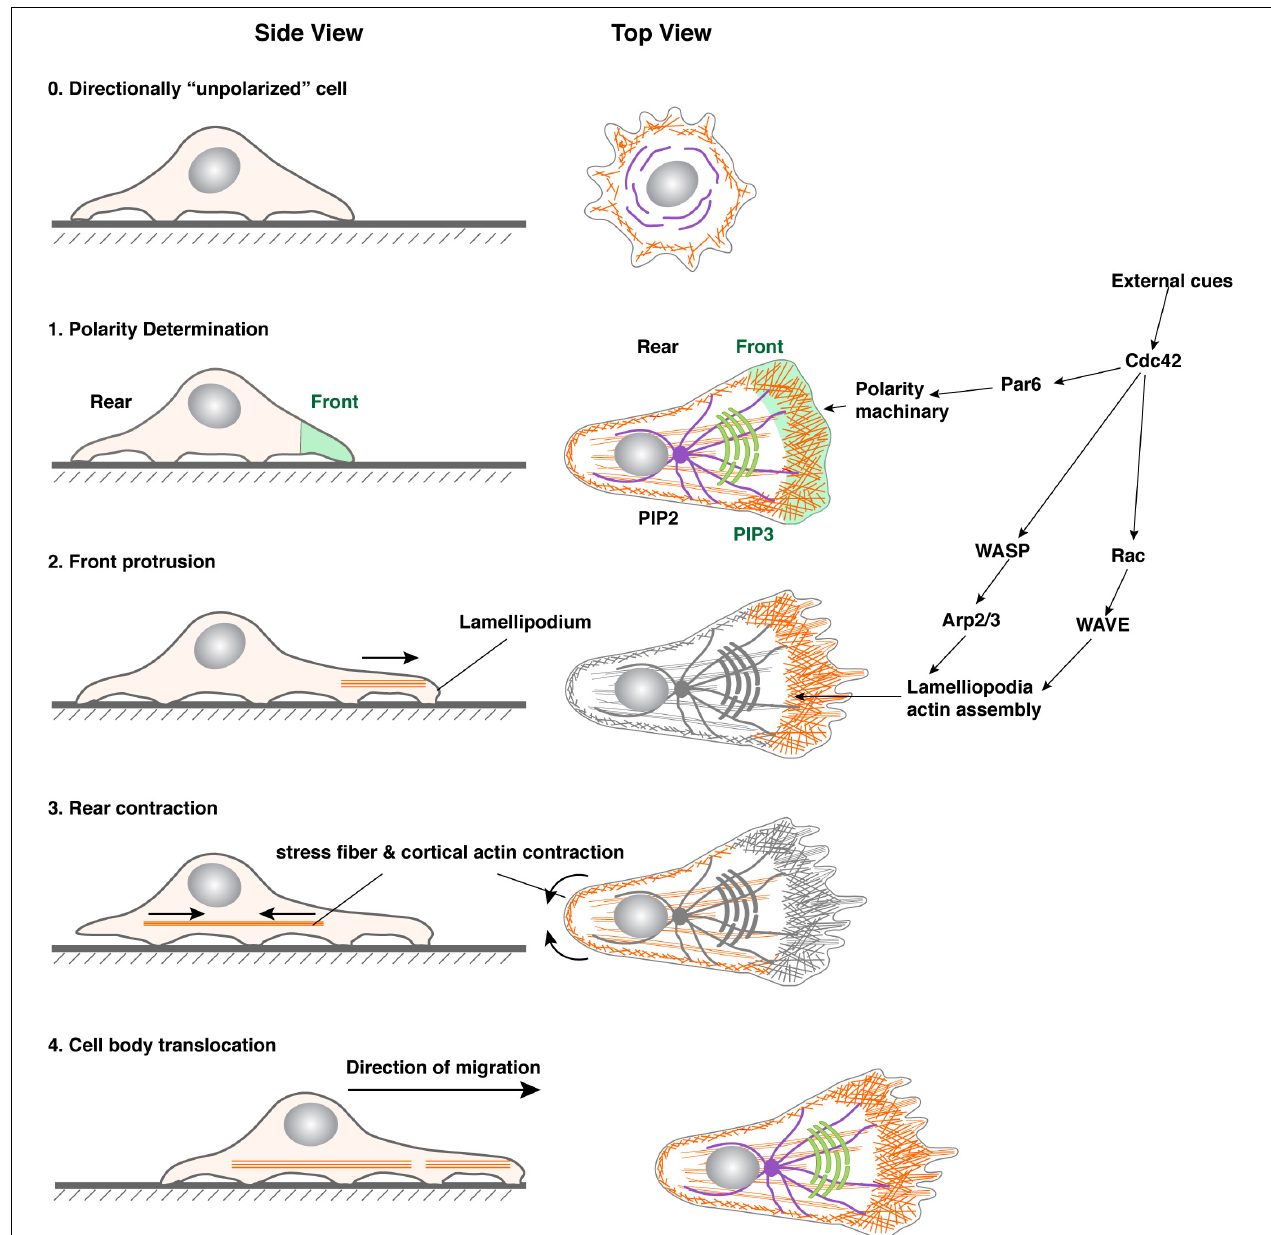
FIGURE 2 | Steps in single-cell migration. Diagram with both side and top views of a cell before and during migration to illustrate signaling events leading to polarity determination, microfilament dynamics, and morphological changes of the cell. For illustration purposes, a cell is theoretically “unpolarized” before being stimulated by an external cue (0). Upon stimulation, the area with the highest Cdc42, Par6, and downstream signaling activities becomes the front, which is marked by an increase in PIP3 levels in the membrane and focal adhesions assembly (1). As a result, lamellipodia formation starts in the front, leading to membrane forward protrusion, where new focal adhesions can be made (2). Concordantly, the rear of the cell undergoes a contraction process (arrowheads) involving actomyosin activities along the cell periphery and in the stress fibers (3). The cell retracts when focal adhesions in the rear break apart due to the contraction force and, as a result, the cell body translocates forward. The net results of the above steps are a forward movement of the